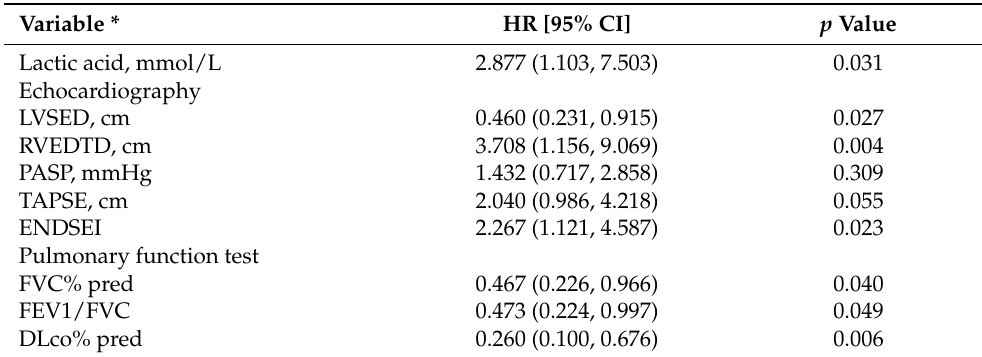
Table 4. Cox univariate regression analyses for all-cause mortality among COPD patients in the derivation cohort.